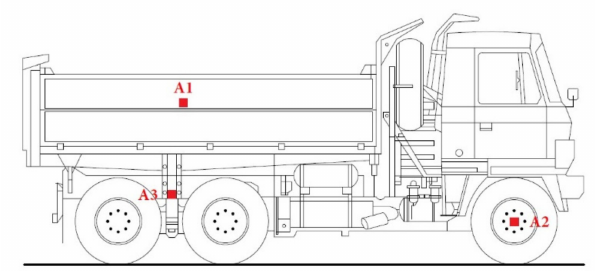
Figure 11. Localization of sensors on the vehicle.